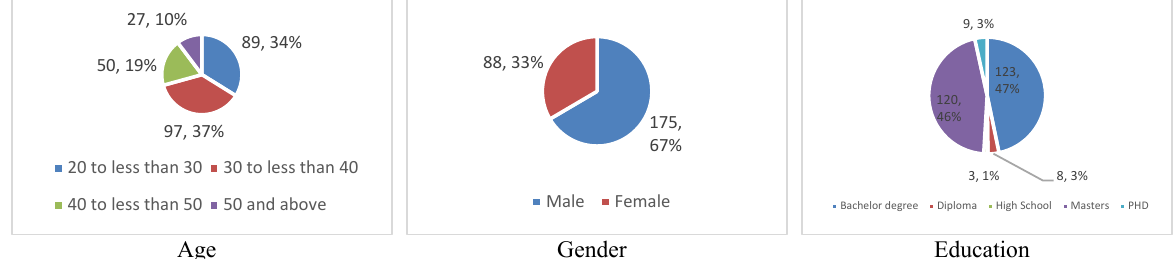
Fig. 2. Demographic information- Gender, Age, Education